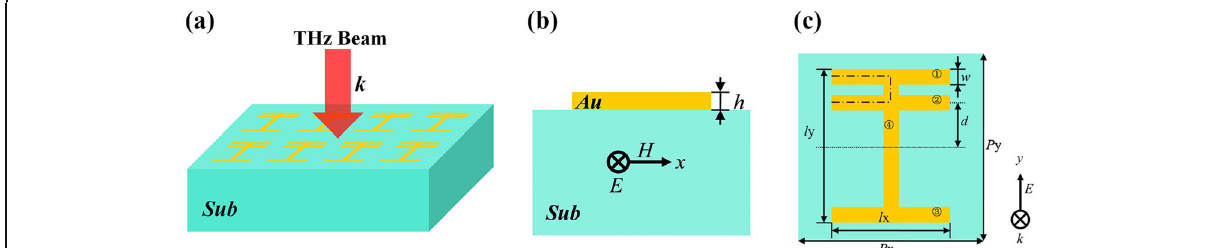
Fig. 1 Three-dimensional diagram of the proposed metamaterial ( a ). Side view ( b ) and top view ( c ) of the asymmetric metamaterial resonator; the equivalent length l is marked by dot-dash